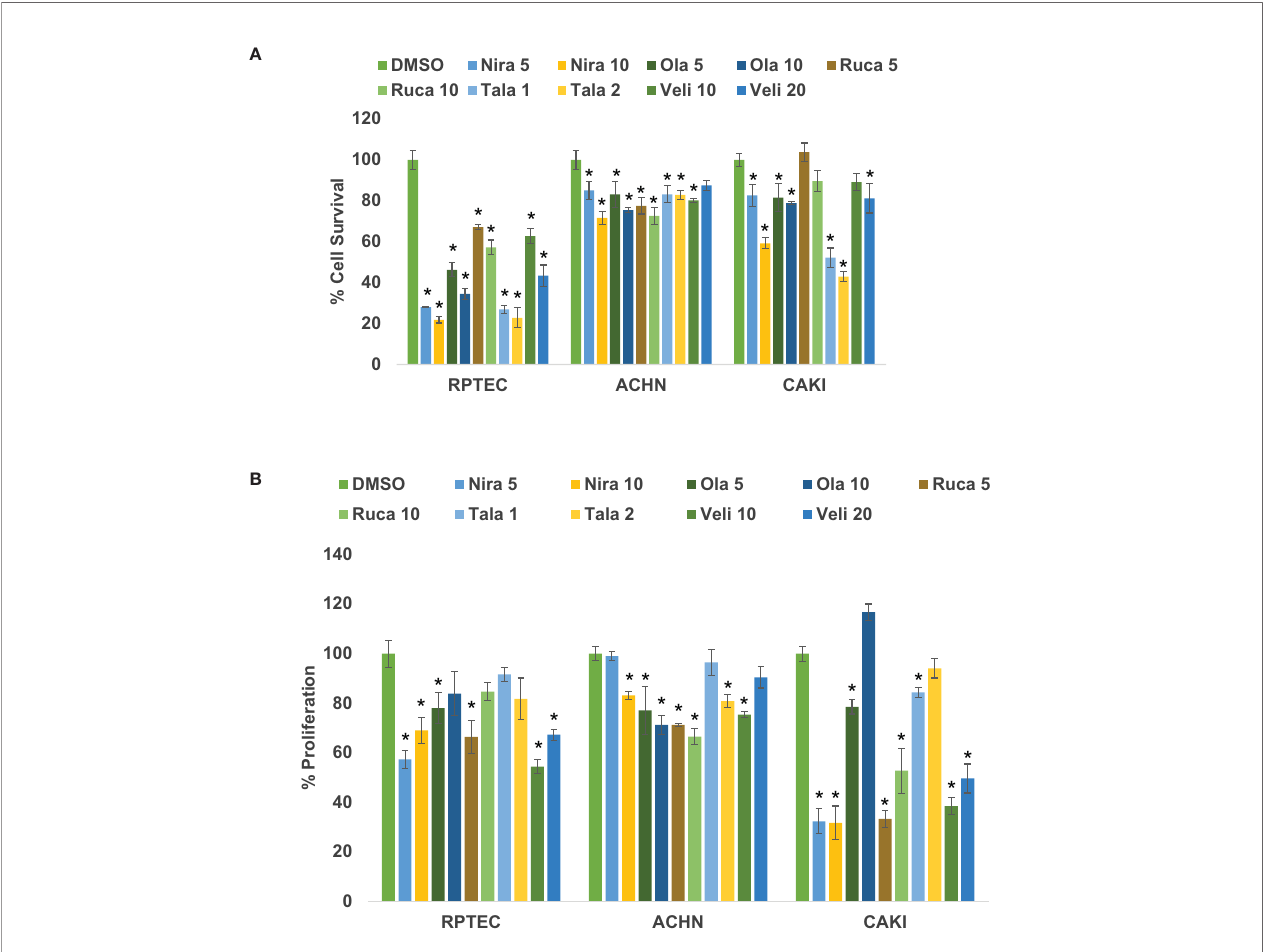
FIGURE 1 | (A) PARPi suppressed the survival of human RCC cells. RPTEC/TERT1, ACHN, and Caki-2 were treated with 5 or 10 m M each of niraparib, olaparib, or rucaparib; 1 or 2 m M talazoparib; or 10 or 20 m M veliparib for 72 h and cell survival was measured by cell counting (Beckman Coulter). Cell survival was calculated as the number of cells remaining attached in each treatment compared with the control (DMSO). Results are presented as means ± SD of 3 separate experiments with triplicates. P < 0.05 was considered signi fi cant (*). Niraparib and talazoparib were effective in reducing the cell survival of RCC cells. (B) PARPi inhibited the proliferation of RCC cells. RPTEC/TERT1, ACHN, and Caki-2 cells were treated with 5 or 10 m M each of niraparib, olaparib, or rucaparib; 1 or 2 m M talazoparib; or 10 or 20 m M veliparib for 72 h and cell proliferation was measured using the CellTiter 96 cell proliferation assay (Promega). Cell proliferation is reported as % cell proliferation compared with control (DMSO). Results are presented as means ± SD of 3 separate experiments with triplicates. P< 0.05 was considered signi fi cant (*). Niraparib, rucaparib, and talazoparib were effective in reducing the proliferation of RCC